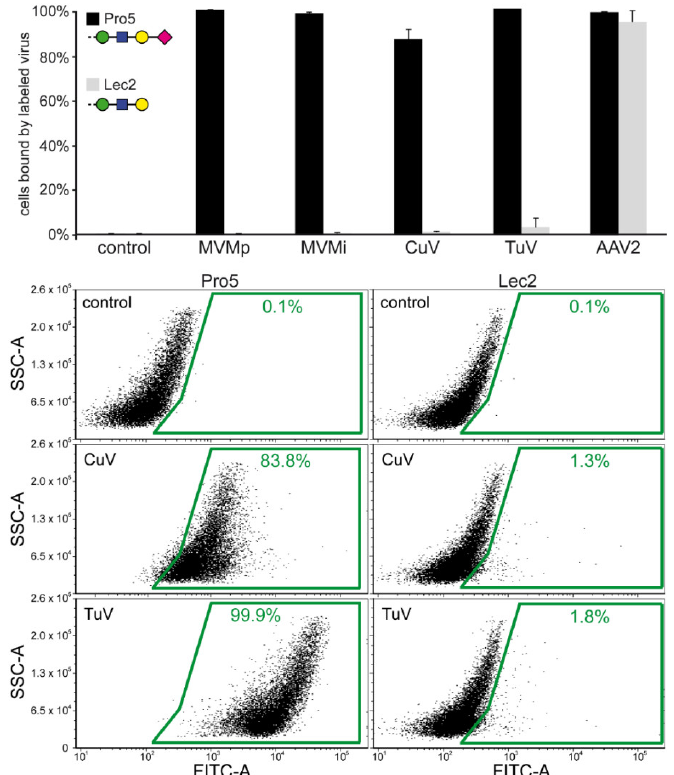
Figure 7. SIA is the attachment receptor for CuV and TuV. The percentage of cells with fluorescent signal are shown for the di ff erent viruses tested as a histogram. AAV2 was tested as a positive control for both cell lines. Shown below are example FACS histograms for control cells, and cells incubated with either fluorescently-labeled CuV or TuV